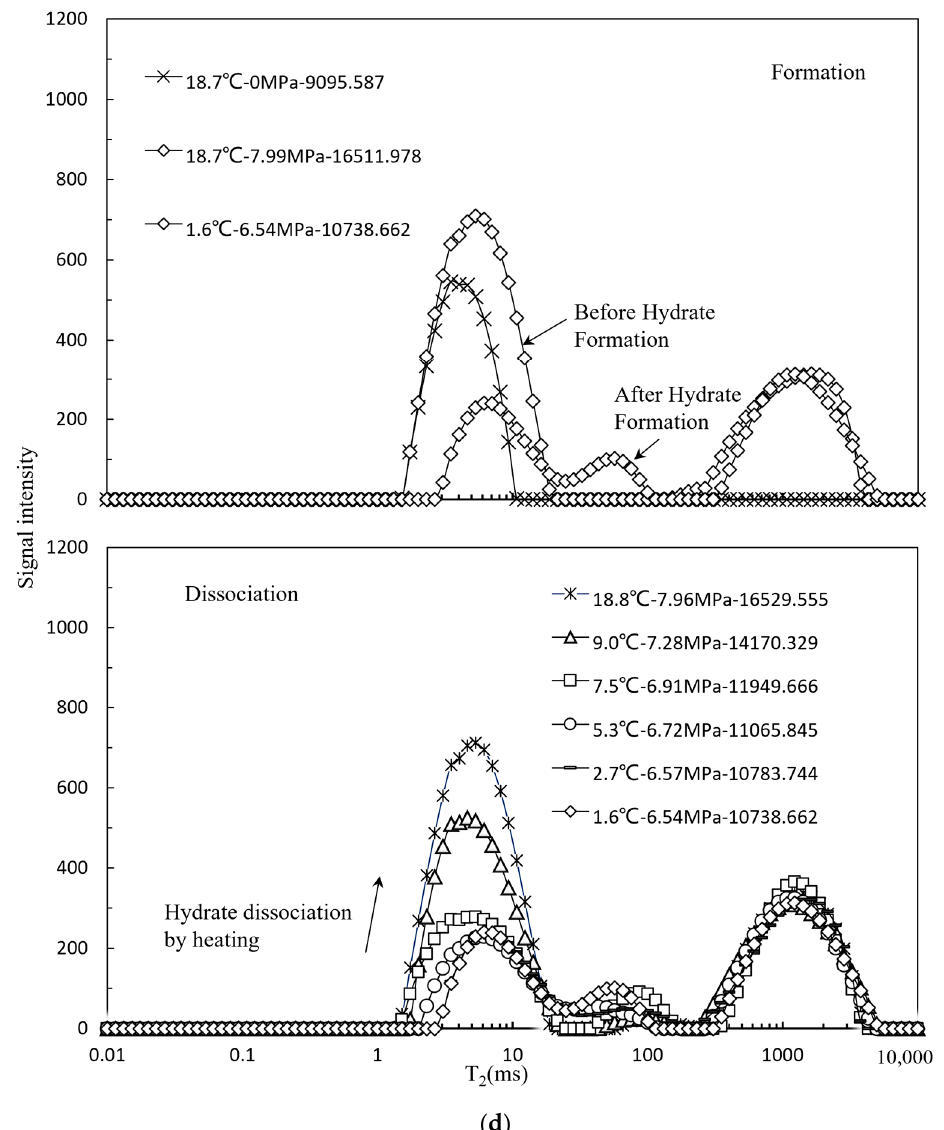
Figure 10. T 2 distribution curve during synthesis and decomposition of methane hydrate in silt. ( a ) ρ = 1.6 g/cm 3 , S W0 = 48.10%; ( b ) d = 1.6 g/cm 3 , S W0 = 20.40%; ( c ) d = 1.5 g/cm 3 , S W0 = 41.00%; ( d ) d